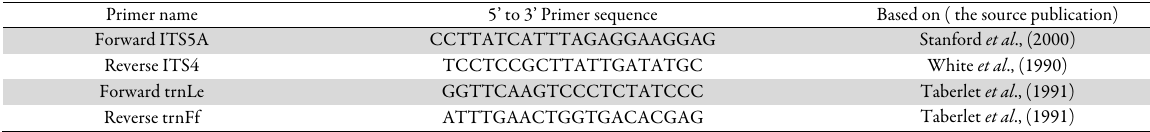
Table 1. ITS and trn L-F primers used for the study